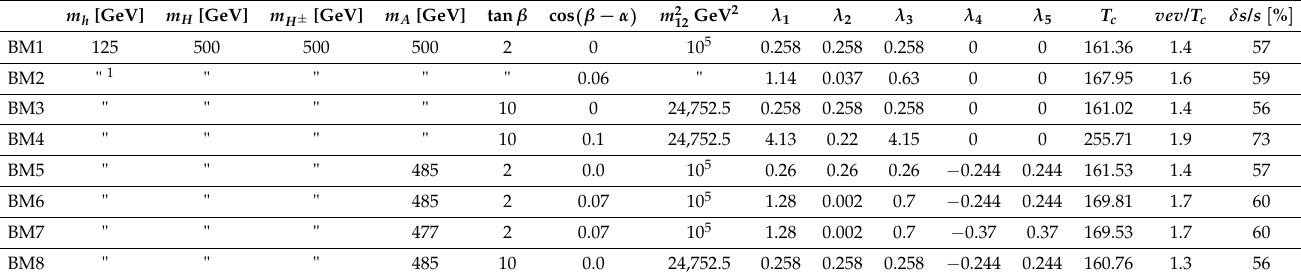
Table 1. 2HDM Benchmark points for entropy